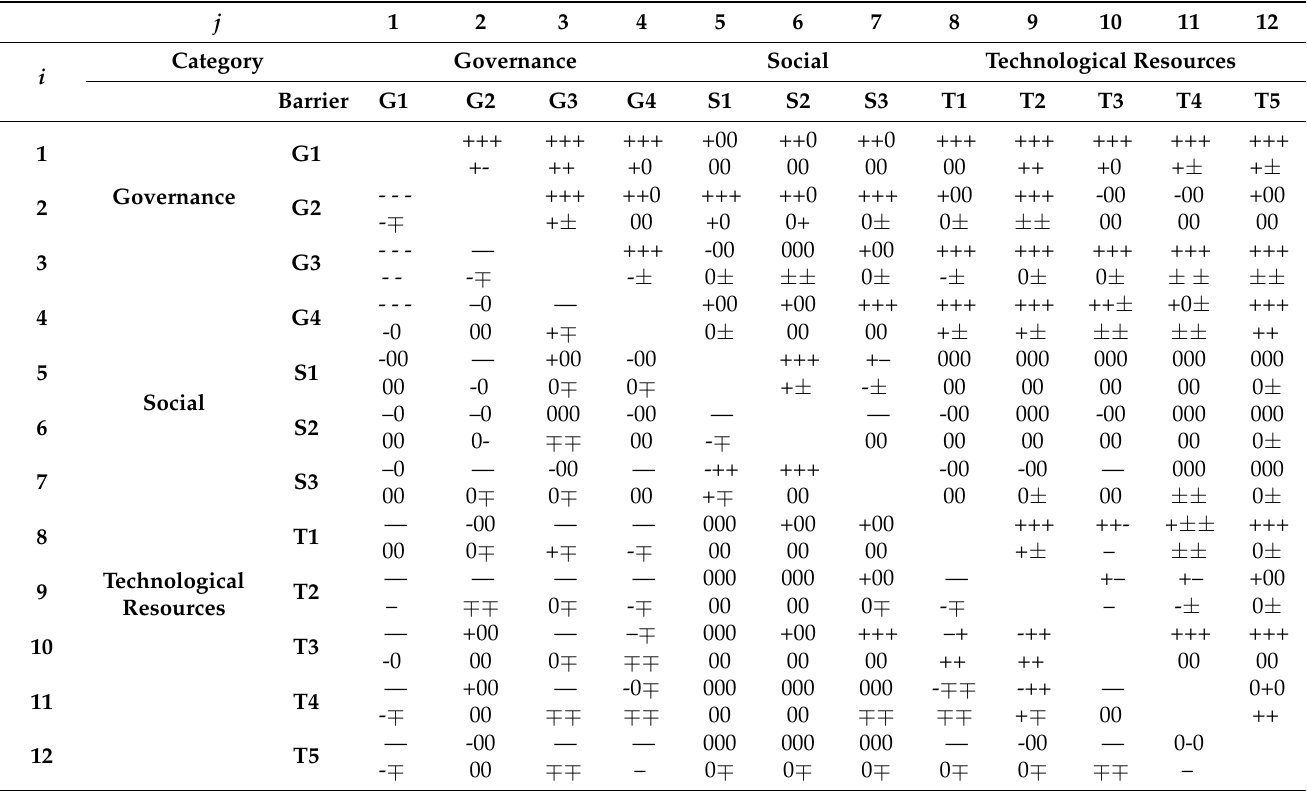
Table 3. Refined Structural Self-Interaction Matrix (refined SSIM).